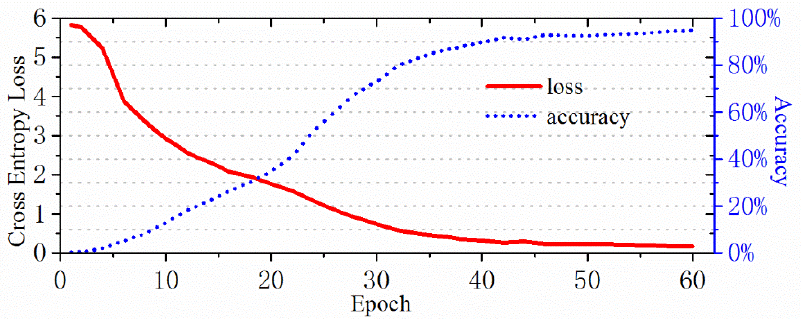
Figure 10. The process of loss and accuracy during model training. The red line is the loss and the blue dot line is the accuracy.